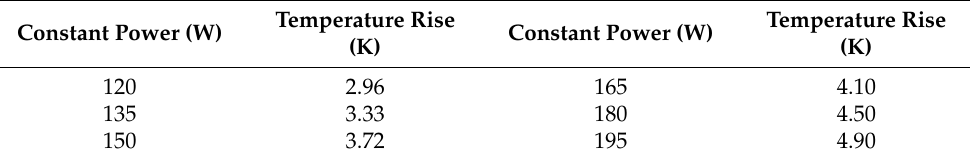
Table 8. Specific temperature-rise